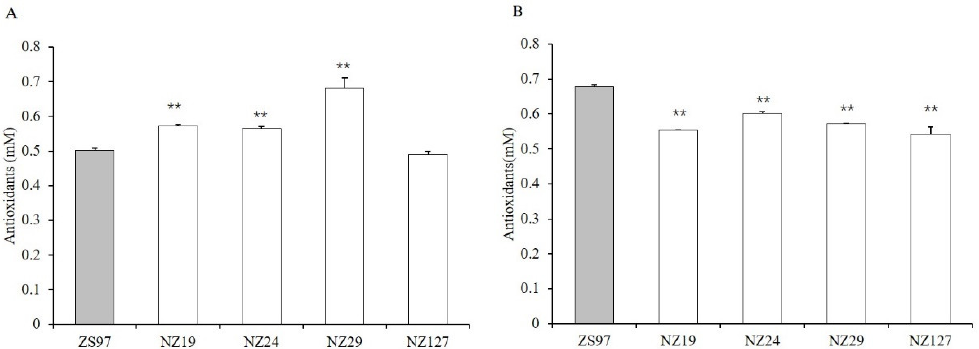
Figure 5. Total antioxidant content in rice seeds. ( A ) Total antioxidant content of unaged rice seeds; ( B ) Total antioxidant content of rice seeds after artificial aging. ** indicates significant difference at p < 0.01. p values were calculated by Student’s t -test.